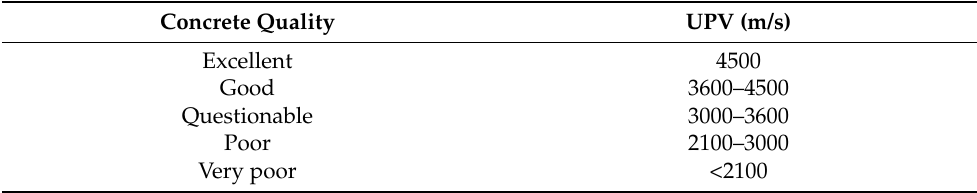
Table 6. Concrete quality classification based on UPV values [49].